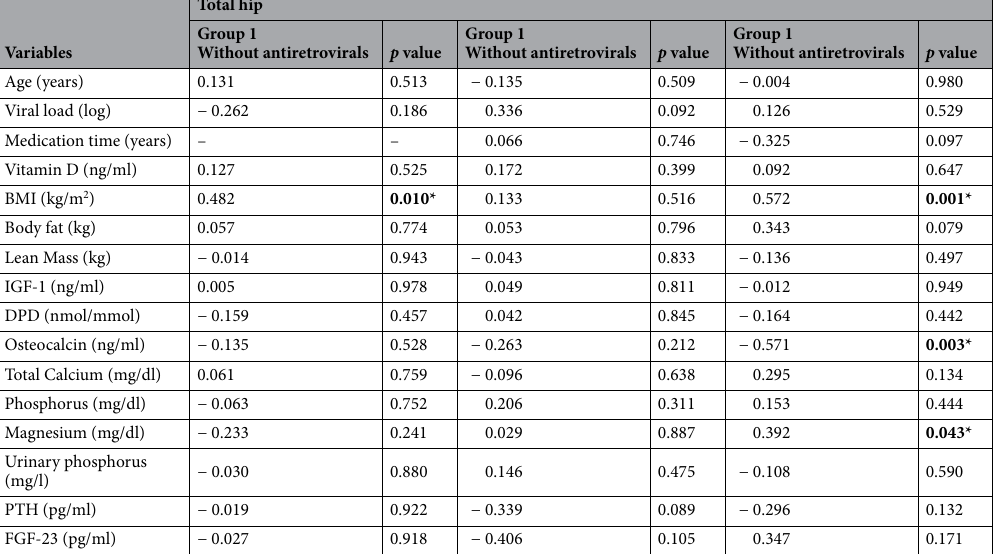
Table 5. Correlation by groups between biochemical markers, body composition and viral parameters with bone mineral density of the total hip in patients with chronic hepatitis B virus infection in use or not of antiretrovirals. Parameters with statistical differences are given in bold. Pearson correlation, significance level p ≤ 0.05 indicated by *. DPD, deoxypyridinoline; PTH, parathormone; IGF-1, insulin-like growth factor-1; FGF-23, fibroblast growth factor 23; BMI, body mass index. FGF-23 n = 16–17 per